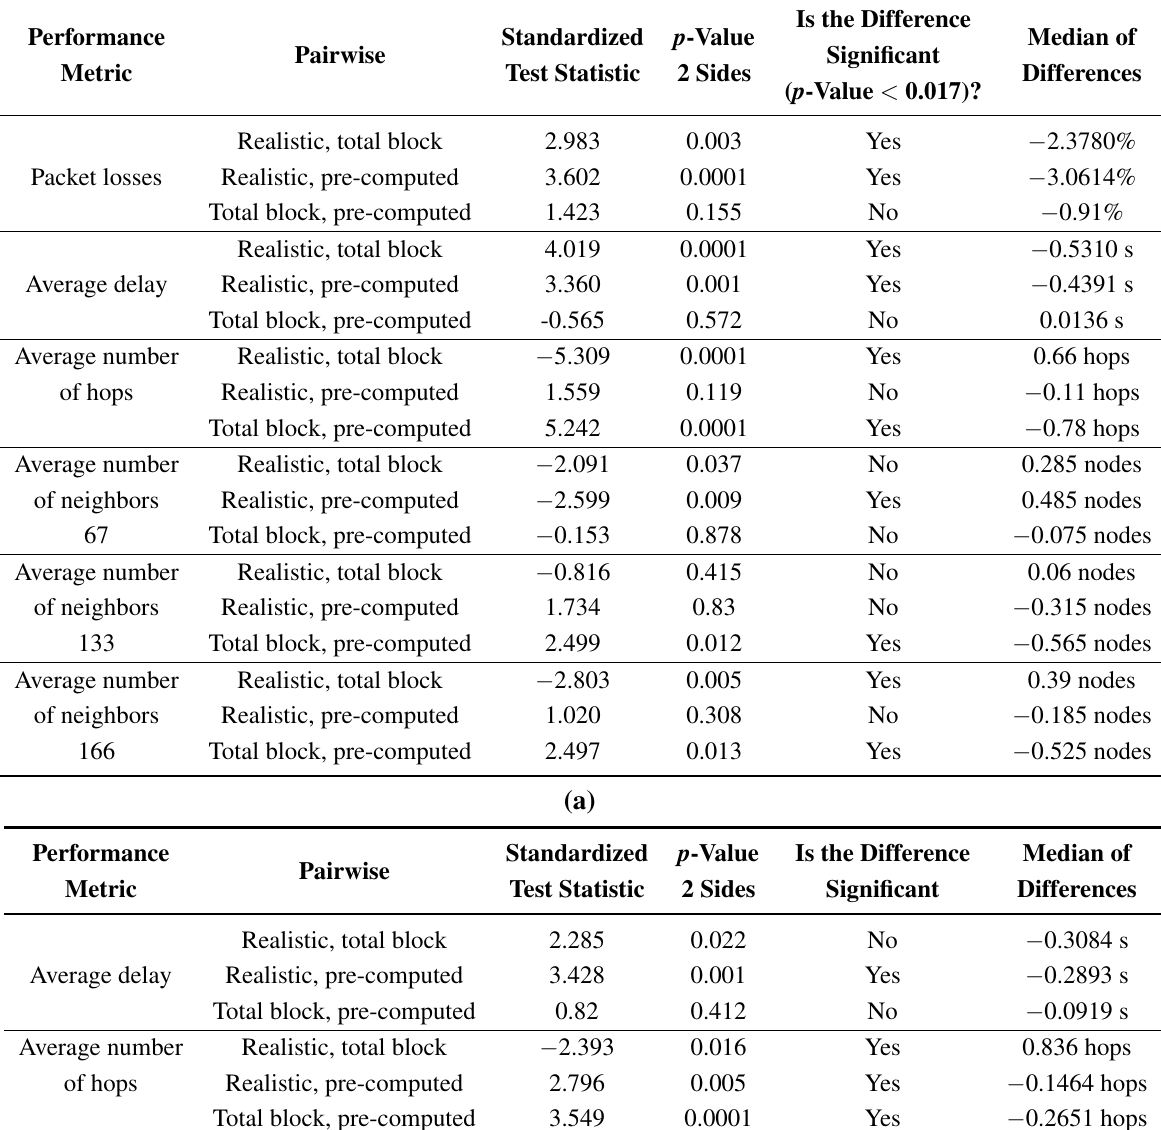
Table 4. p -Values of Wilcoxon signed rank test for a pairwise comparison of the building attenuation model effect. ( a ) Barcelona scenario. 1 AP. Uniformly distributed traffic; ( b ) Tarragona scenario 6 APs. Exponentially distributed